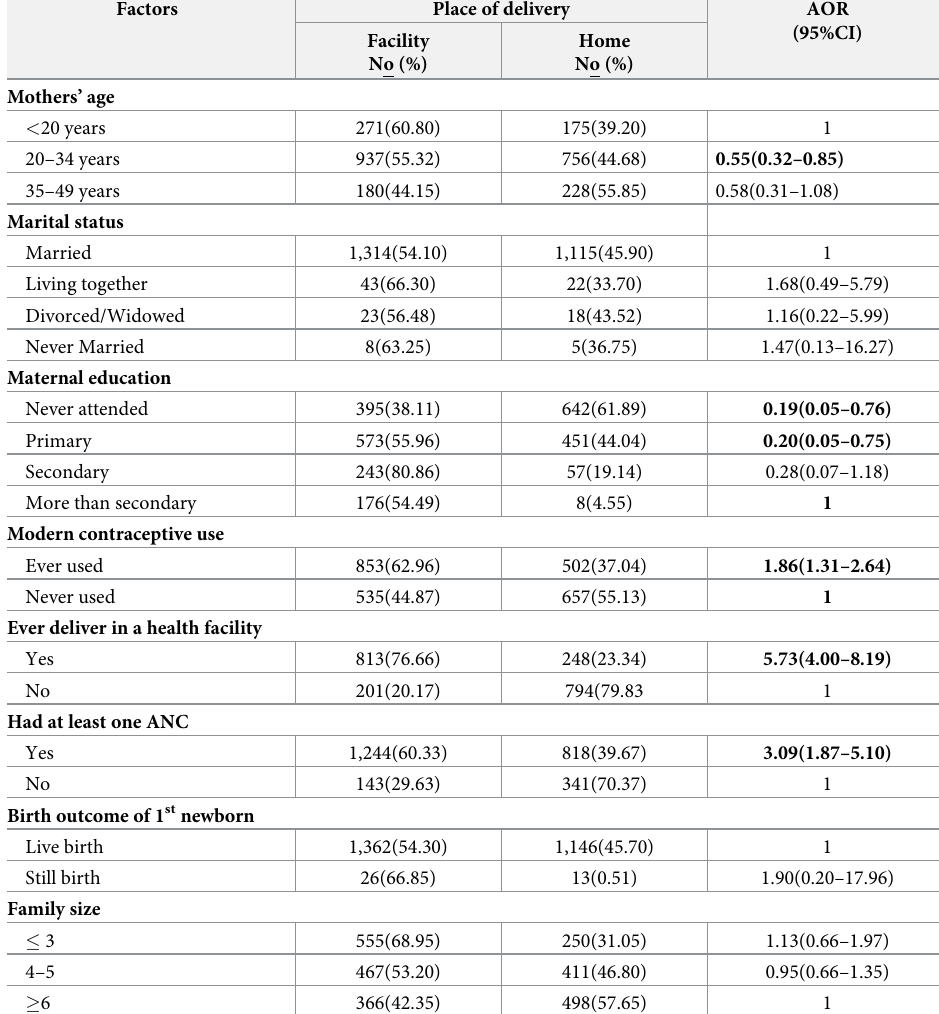
Table 4. Maternal & household factors associated with place of delivery, PMA-Ethiopia